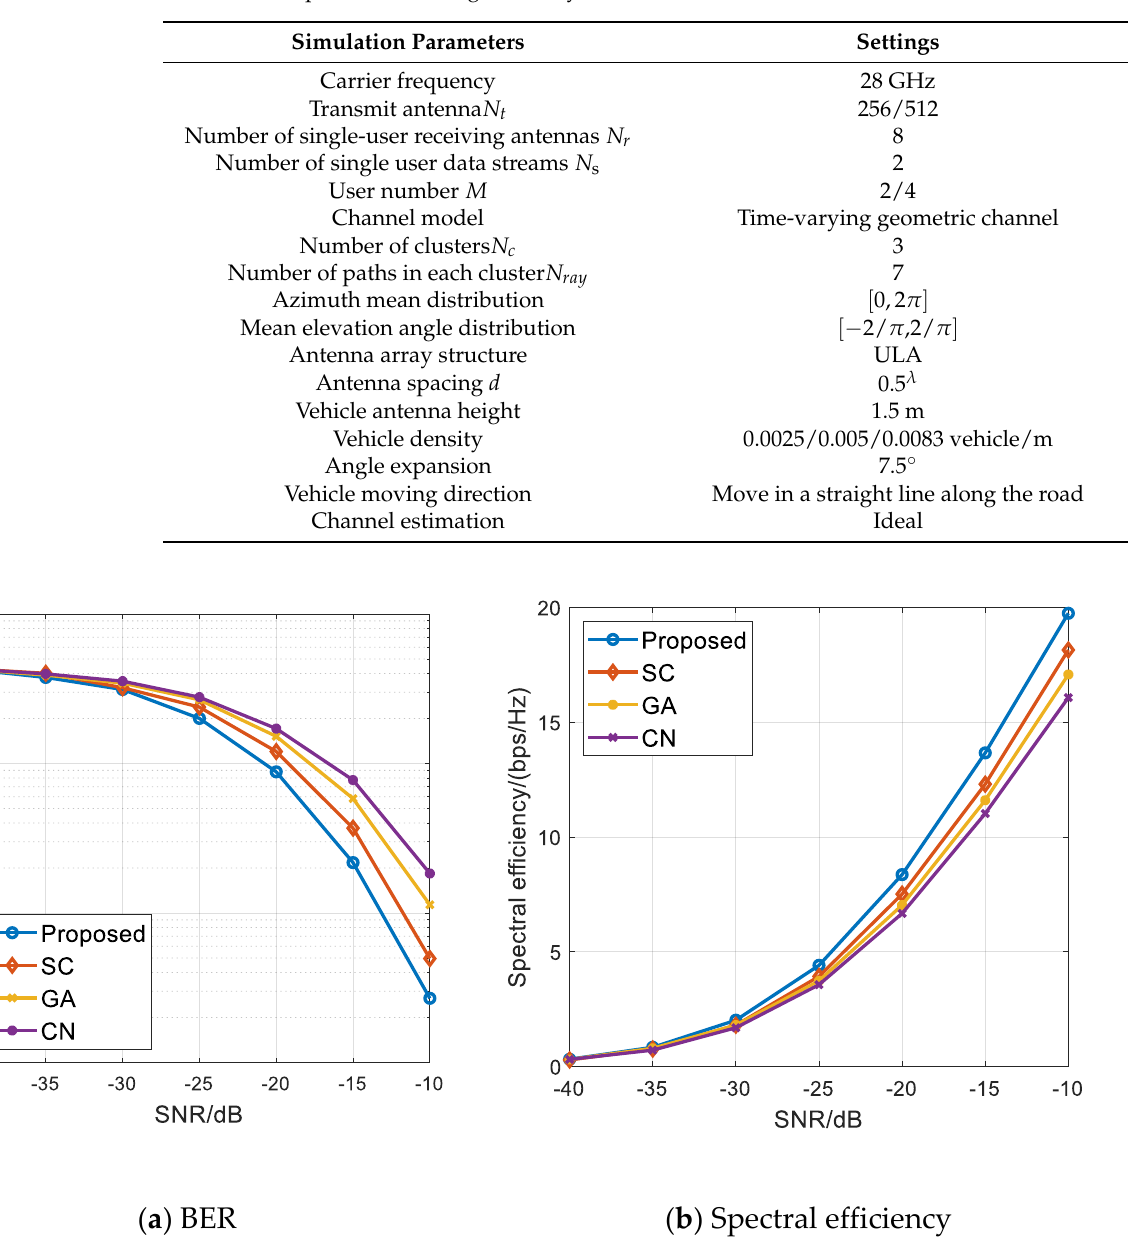
Figure 3. Multi-user scheduling simulation results when M = 2 and N t = 256. ( a ) BER of all the algorithms; ( b ) Spectral efficiency performance of all the algorithms.